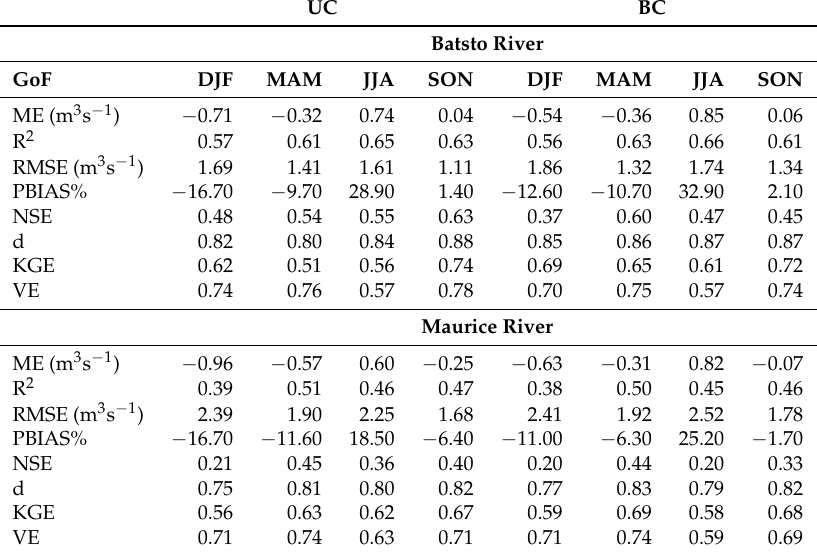
Table 3. Goodness-of-fit (GoF) measures for uncorrected (UC) and bias-corrected (BC) simulated flows. GoF was measured based on seasonally averaged flows. DJF = December, January, and February, etc. Note that seasonal bias correction was not done based on the seasonal definitions used in the